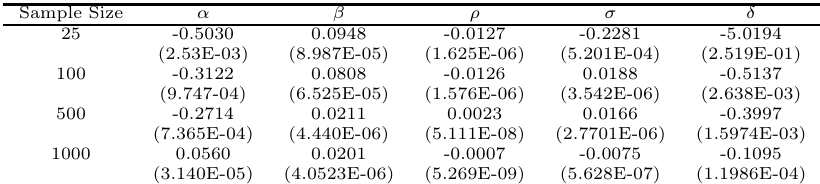
Average bias and mean squared errors(within brackets) of MLEs of the parameters of EKIWD based on simulated data sets corresponding to α = 2 , β = 2 , ρ = 0 . 1 , σ = 0 . 1 , δ = 2